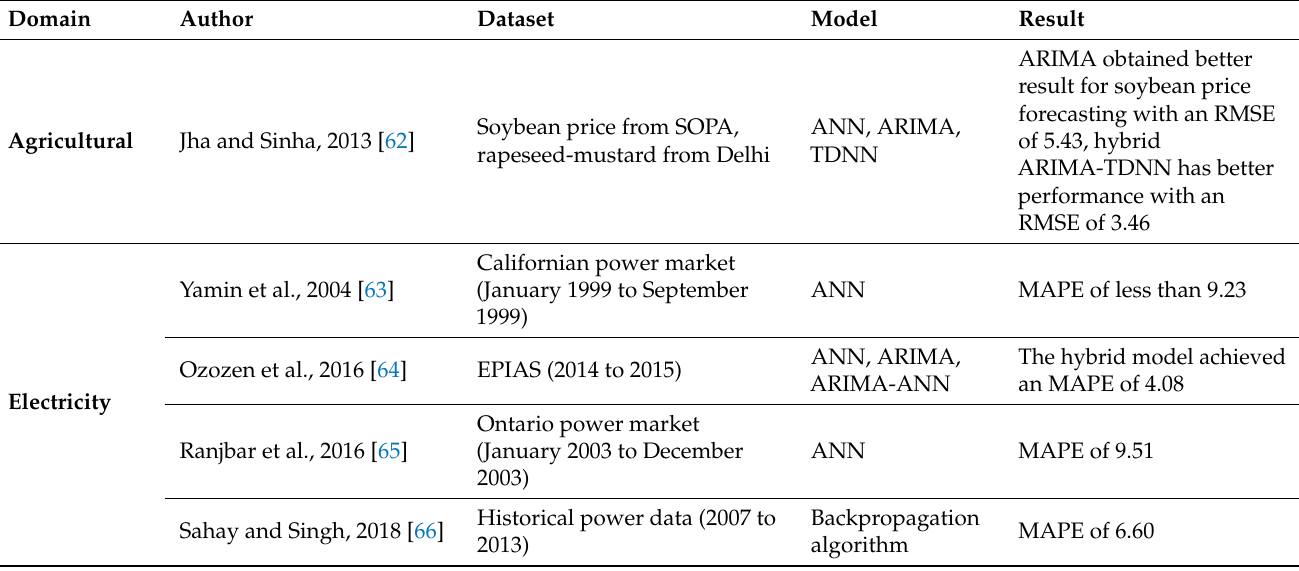
Table 7. ANN time-series forecasting from 2004 to